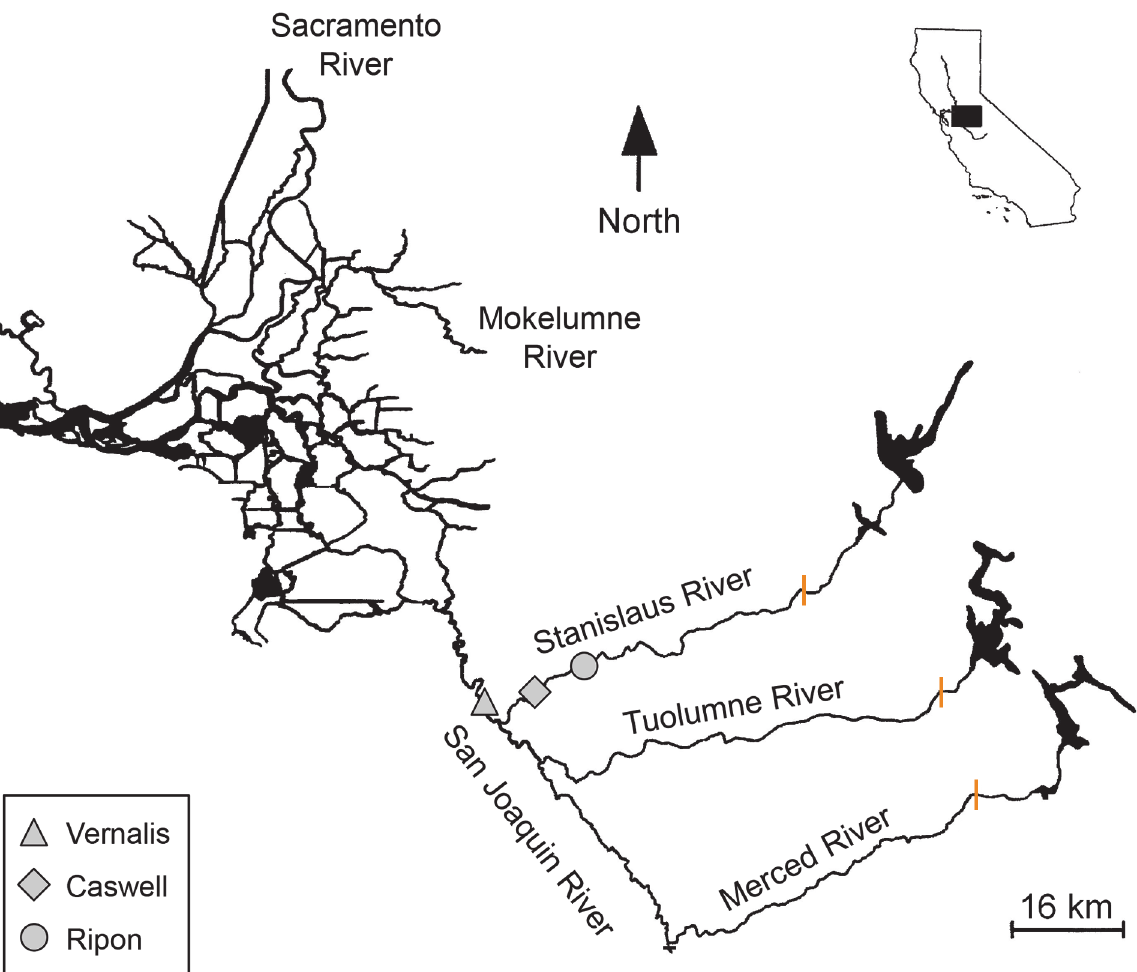
Fig 2. The San Joaquin basin of the Central Valley, California (inset). Map showing the major rivers in the San Joaquin basin, and the location of the rotary screw trap site at Caswell Memorial State Park and USGS gauges at Ripon and Vernalis. The upstream barriers to salmon migration in the three main tributaries are indicated by orange